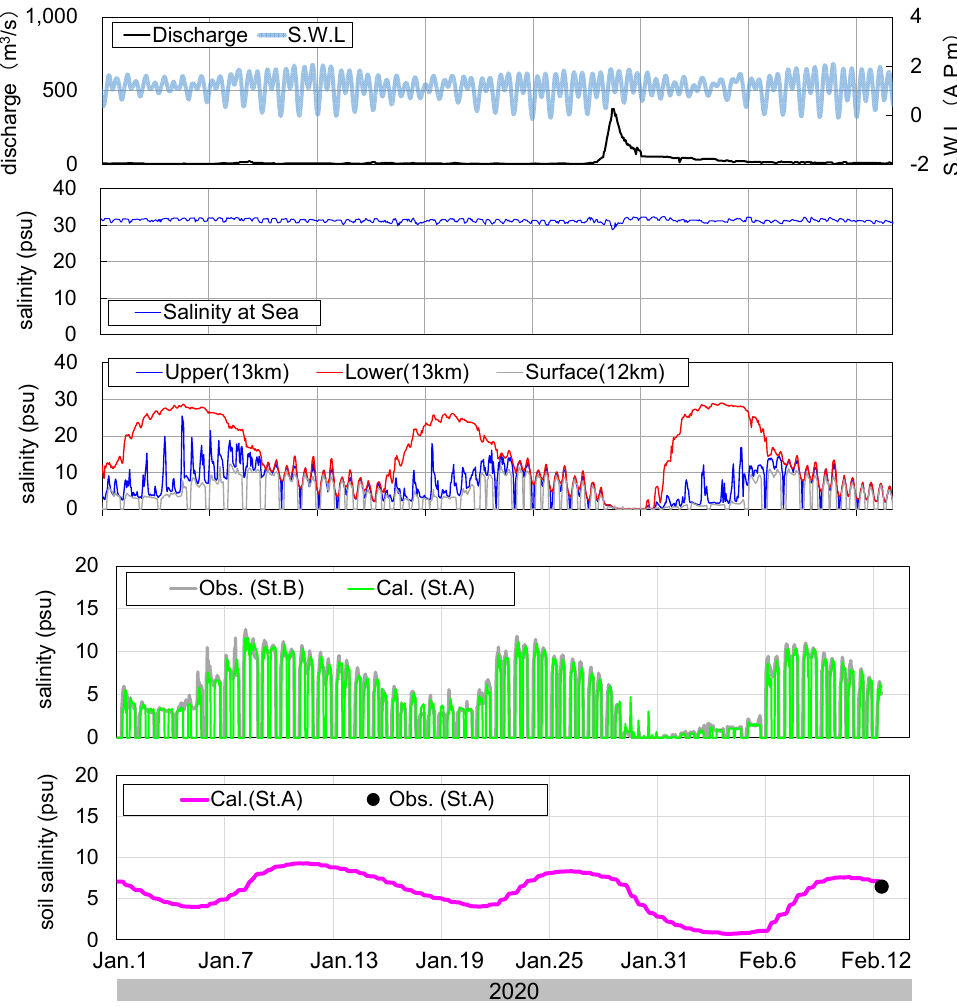
Figure 13. Verification result of soil salinity at St. A, from 1 January to 13 February 2020.